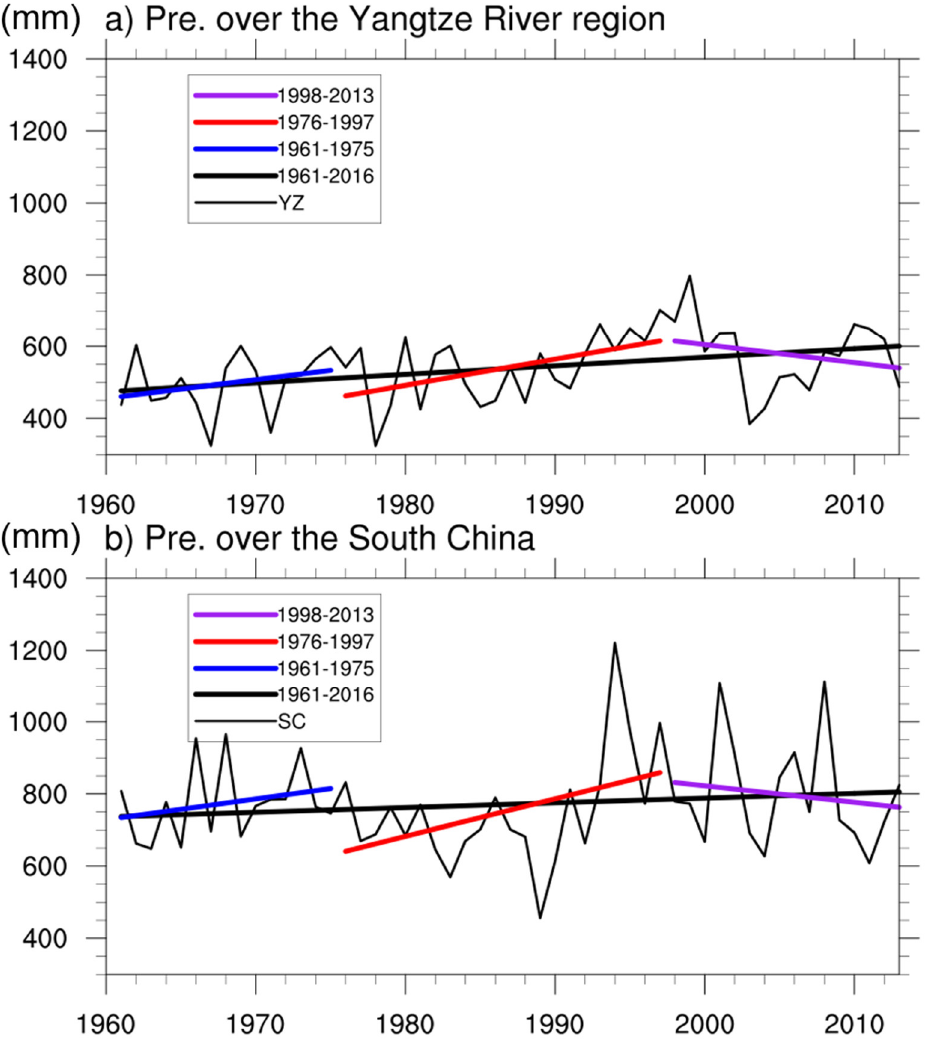
Figure 2. Variation and trend of summer precipitation over ( a ) Yangtze River (25° N–32.5° N,115° E–122° E) and ( b ) South China (20° N–25° N, 105° E–120° E) during different periods. The unit is mm.